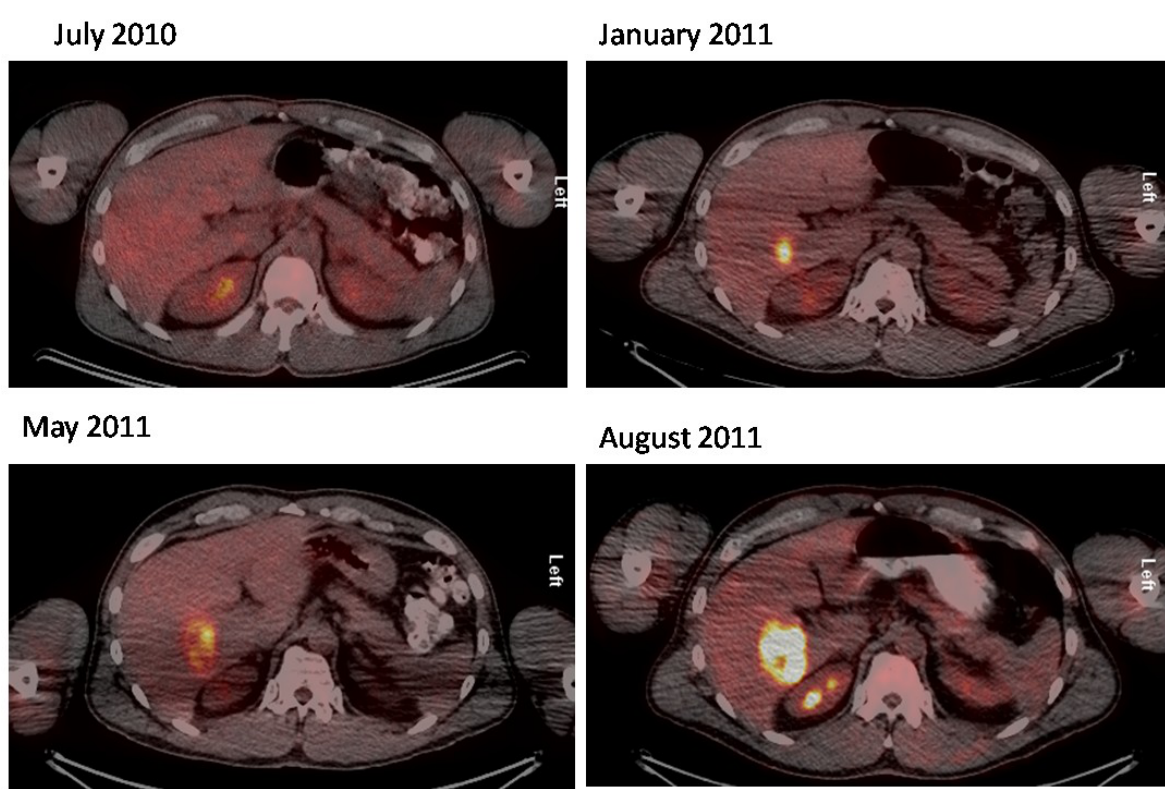
Figure 3. A series of axial fused PET/CT images showing gradual progress in liver metastasis from Merkel cell carcinoma.